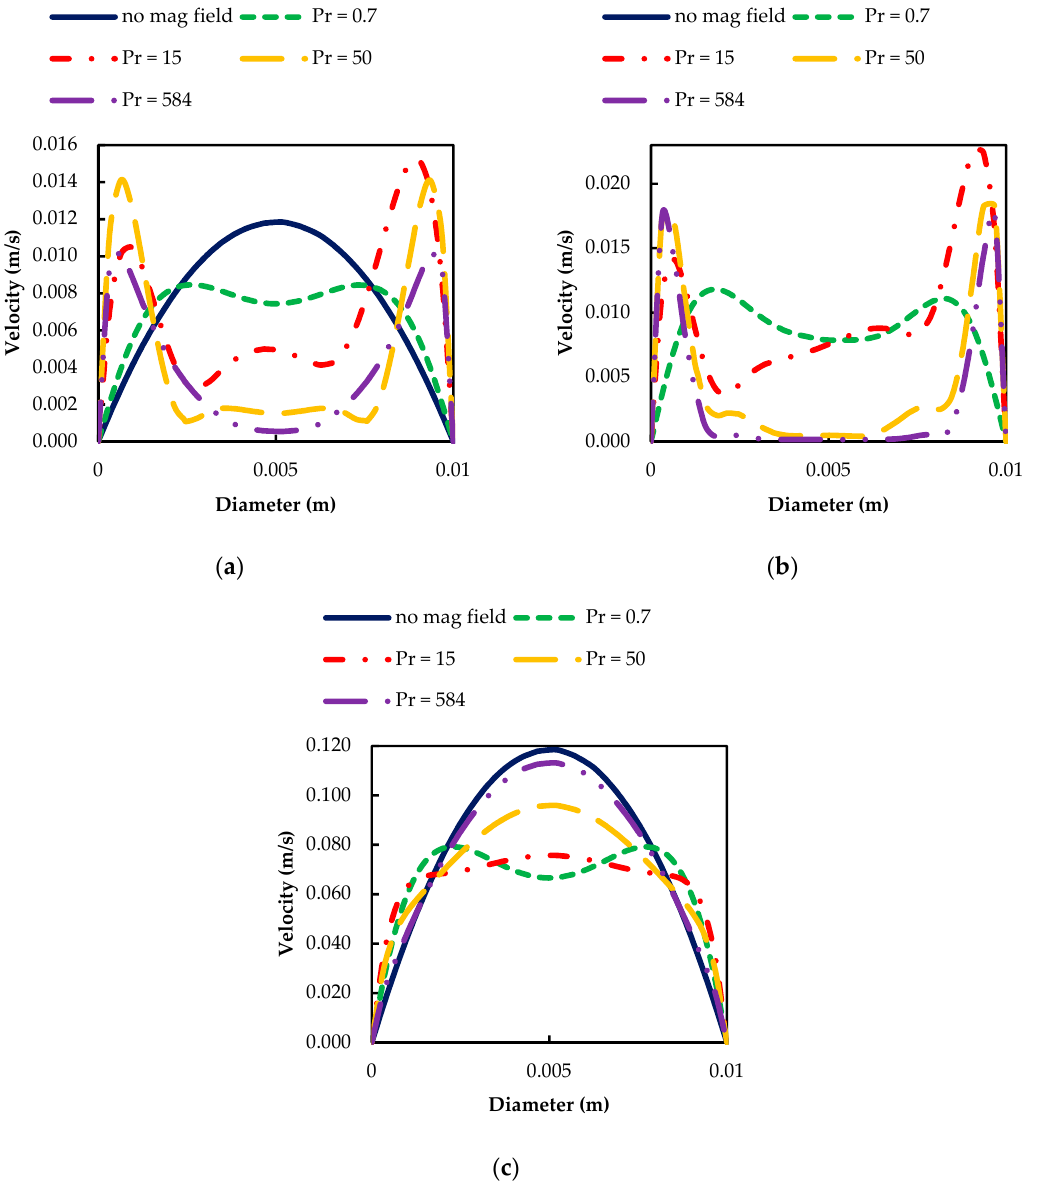
Figure 15. Velocity profiles obtained for the studied cases in the cross-section placed 0.005 m behind the magnetic coil: ( a ) Re = 1, b 0 = 5 T, ( b ) Re = 1, b 0 = 10 T, ( c ) Re = 10, b 0 = 5 T.